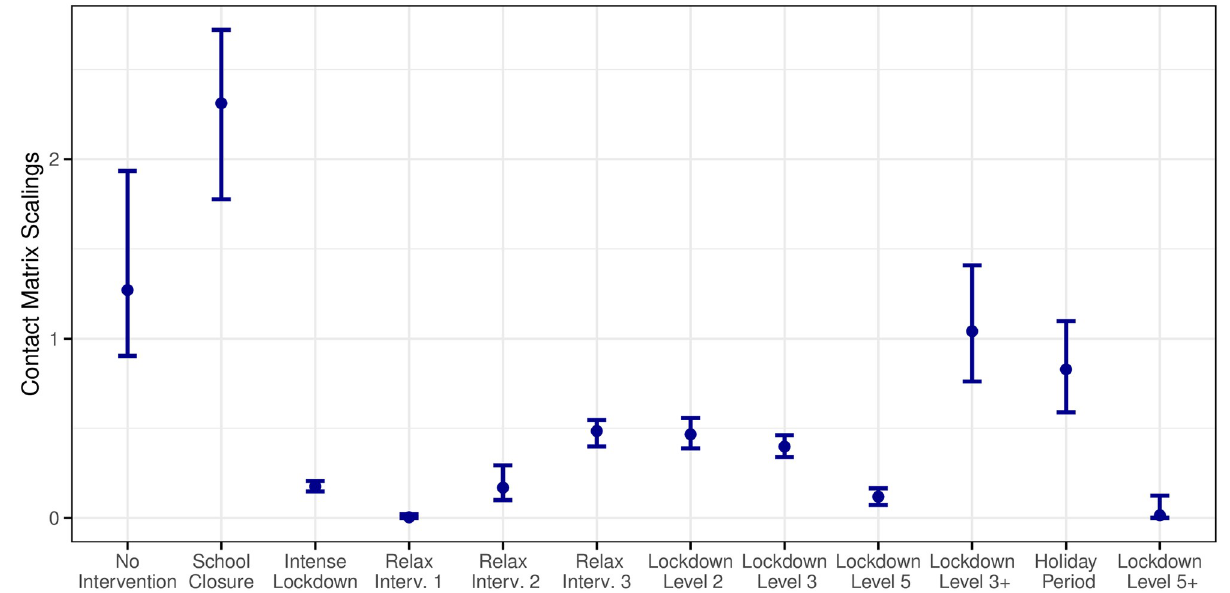
Fig 6. Estimates of the contact matrix scaling parameters for each lockdown period with 95% uncertainty intervals obtained through bootstrapping.